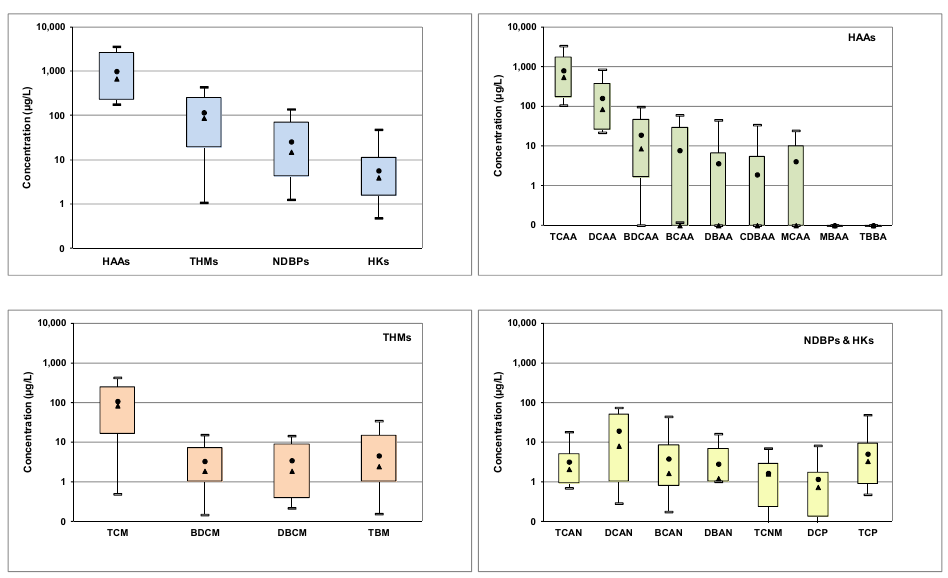
Figure 2. Water concentrations of DBPs in swimming pools (boxplots represent 10th and 90th percentiles, min and max values; circle and triangle represent mean and median values, respec- tively).